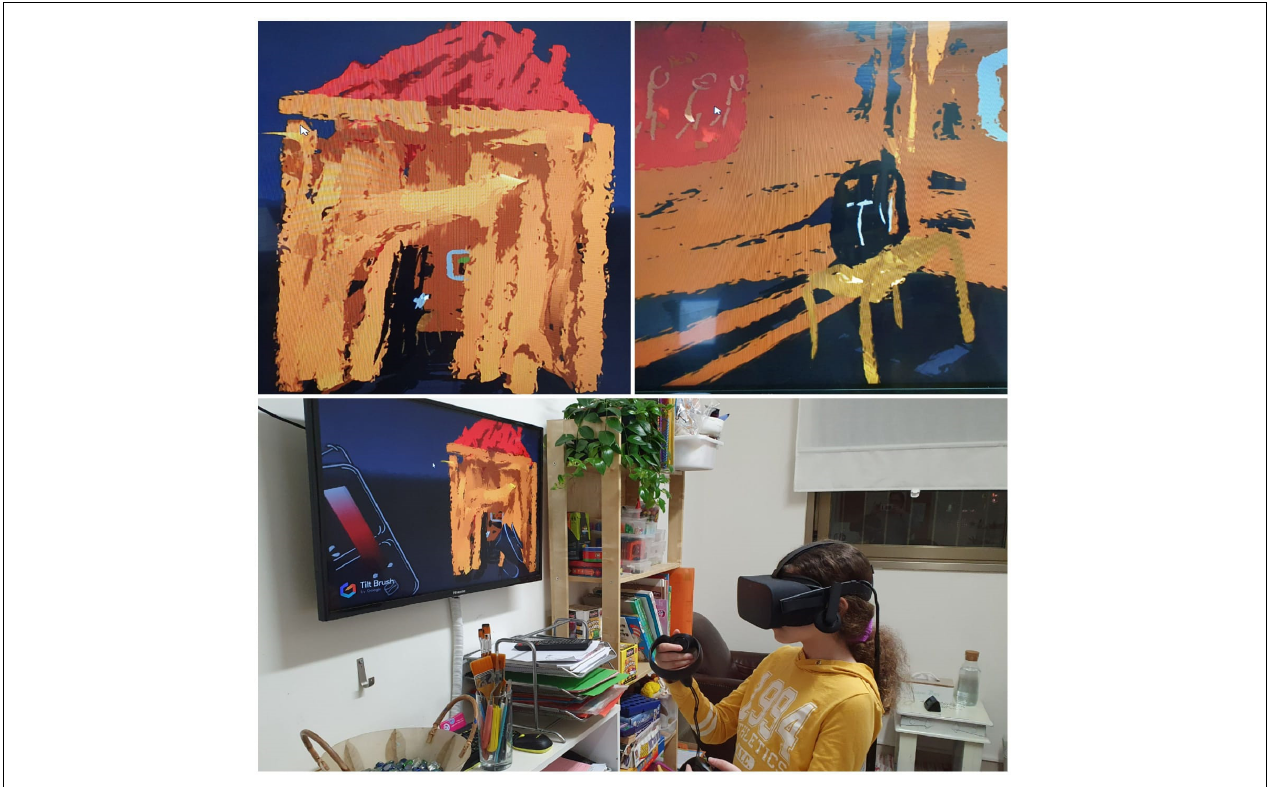
FIGURE 2 | House via multiple